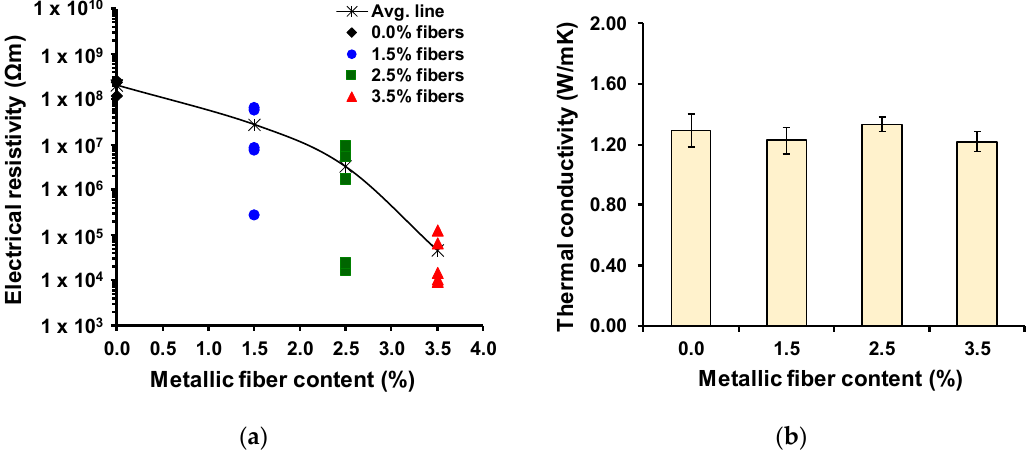
Figure 9. Results of ( a ) electrical resistivity and ( b ) thermal conductivity of the asphalt test samples.